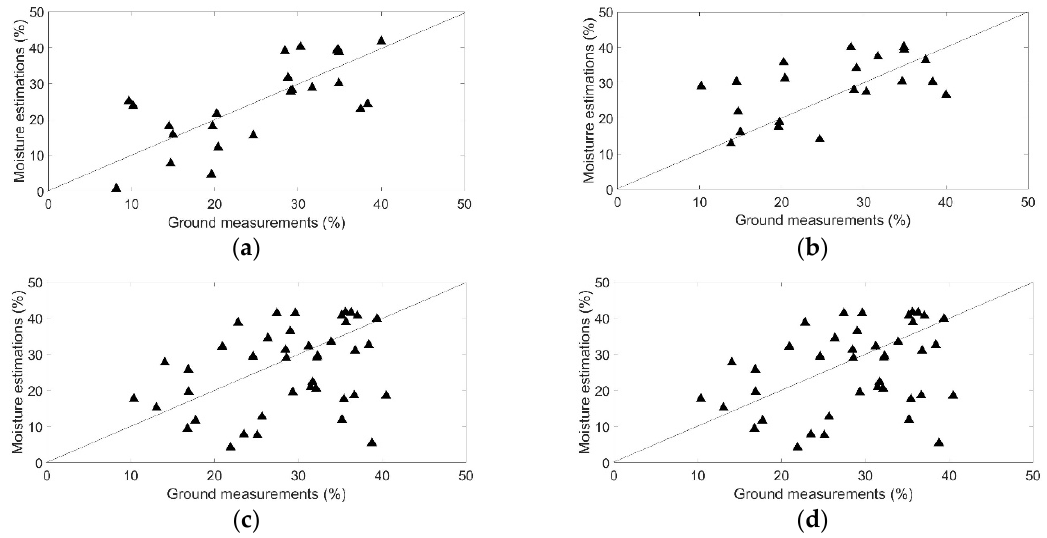
Figure 11. Comparison between ground measurements and estimated soil moisture values using